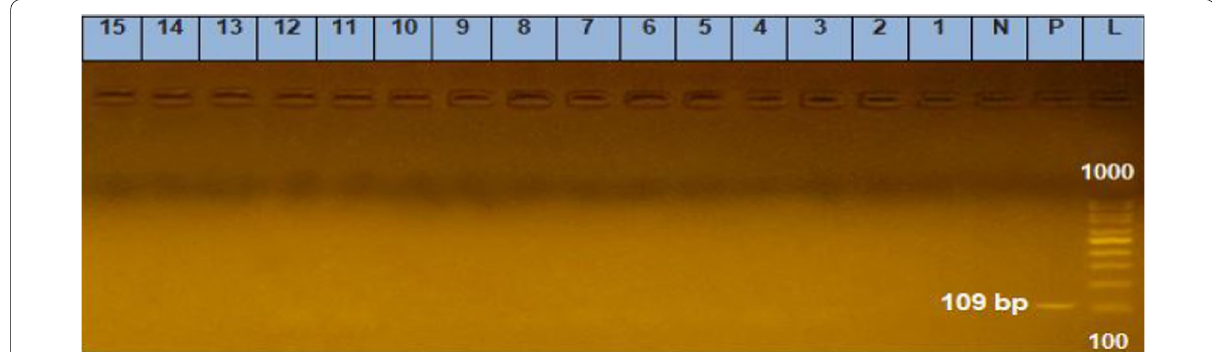
Fig. 14 Agarose gel electrophoresis showing amplification product of 109 bp of Ompk35 . Lane L : Ladder (Marker) 100‑1000 bp plus DNA ladder. Lane P : control positive. Lane N : control negative. Lane 1–15 : examined